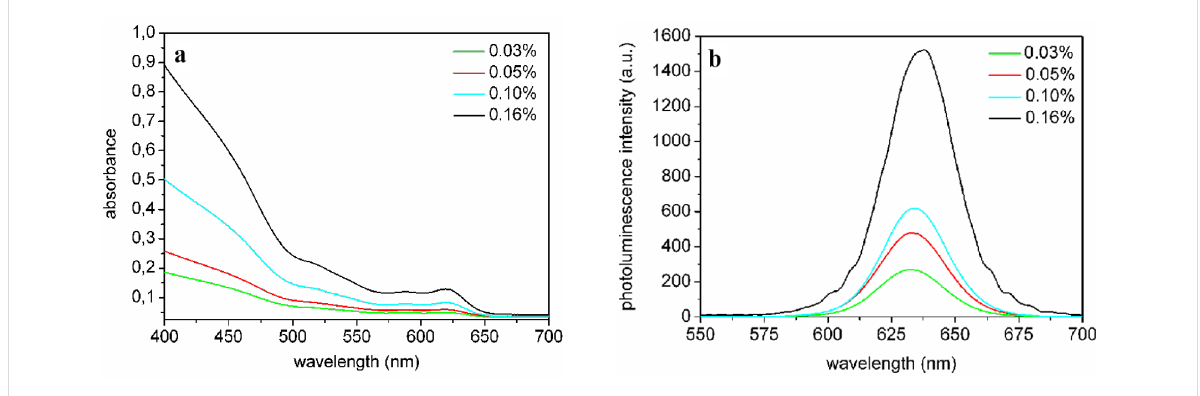
Table 1: QE of P(LMA-co-EGDM) composites and chloroform solu- tions with aspect ratio 3 nanorods. The error in QE is 1%.